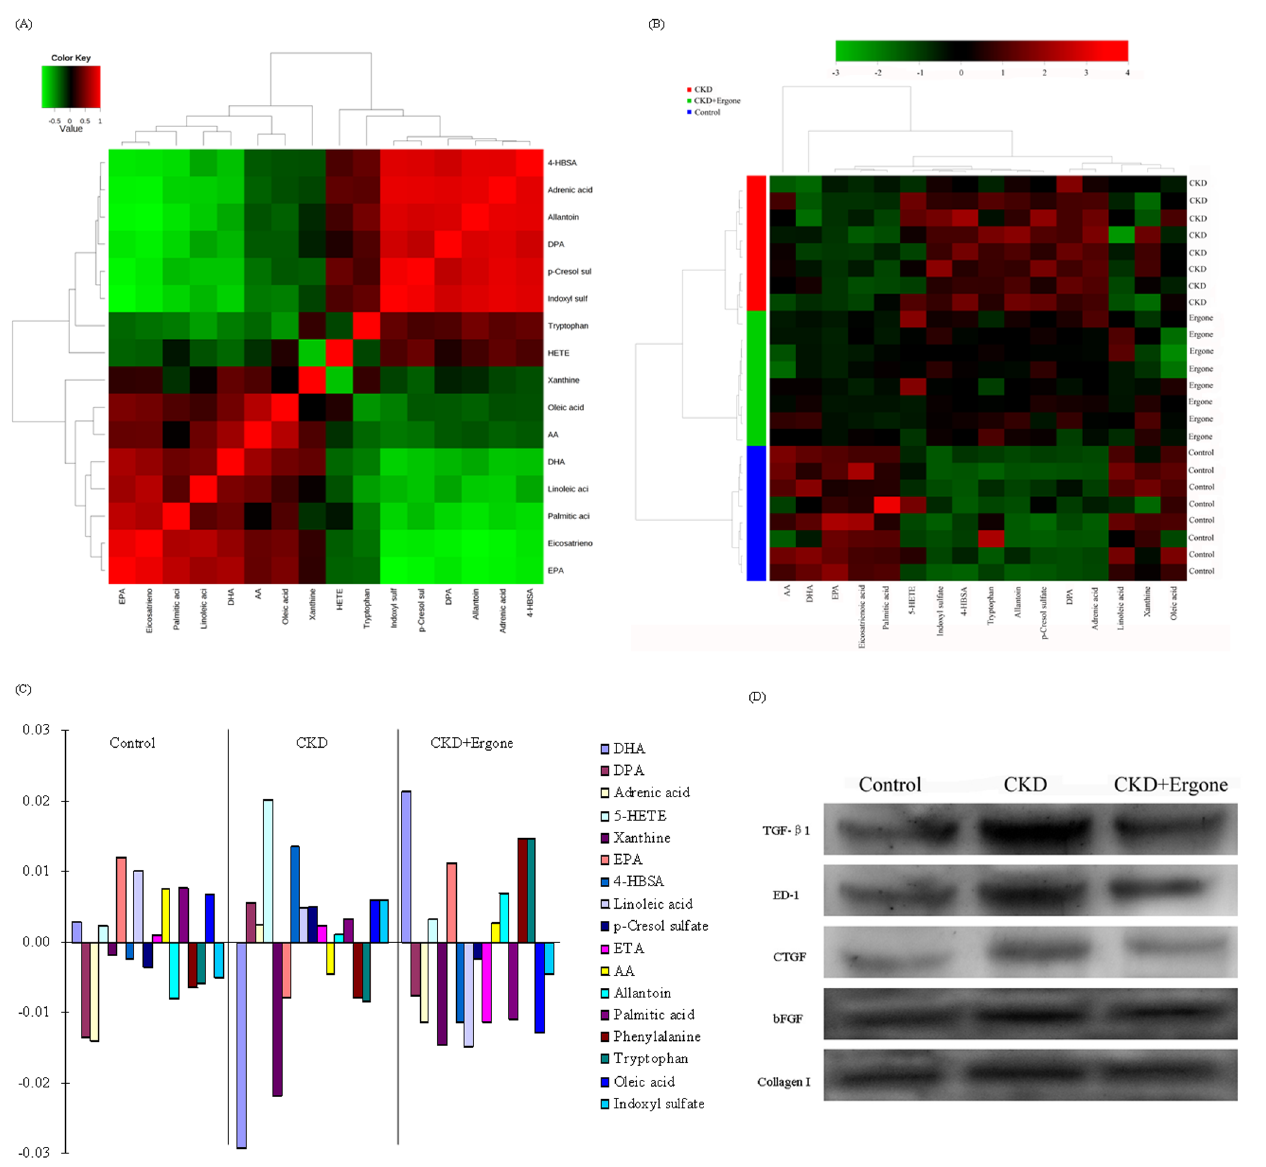
Fig. 5. Multivariate statistical analysis and protein expression in the three different groups. Correlation analysis of the differential metabolites in the different groups (A). Heatmap for kidney of the identified metabolites in the different groups (B). The color of each section is proportional to the significance of change of metabolites (red, upregulated; green, downregulated). Rows: samples; Columns: metabolites. Correlation coefficient analysis among groups with corresponding markers in different groups (C). Variables are presented in control, CKD and CKD + Ergone groups. Values of correlations are shown in the vertical axis (low for negative correlations and upper for positive correlations) and corresponding metabolites represented to the right of the bars. Expression levels of TGF- b 1, ED-1, CTGF, bFGF and Collagen I proteins were determined in the control, CKD and CKD + Ergone groups by Western blot analysis